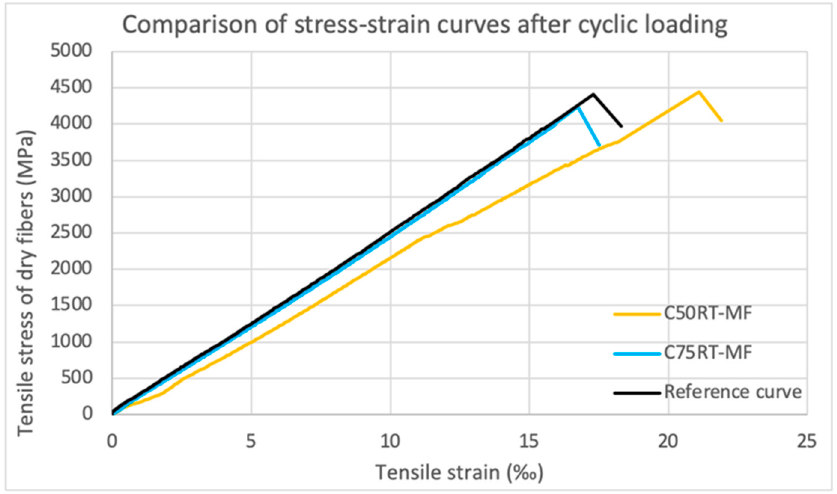
Figure 14. Stress–strain curves of monotonic, uniaxial tension at room temperature after low-cycle fatigue with max load 50% (C50RT-MF) and 75% (C75RT-MF) of the tensile strength.